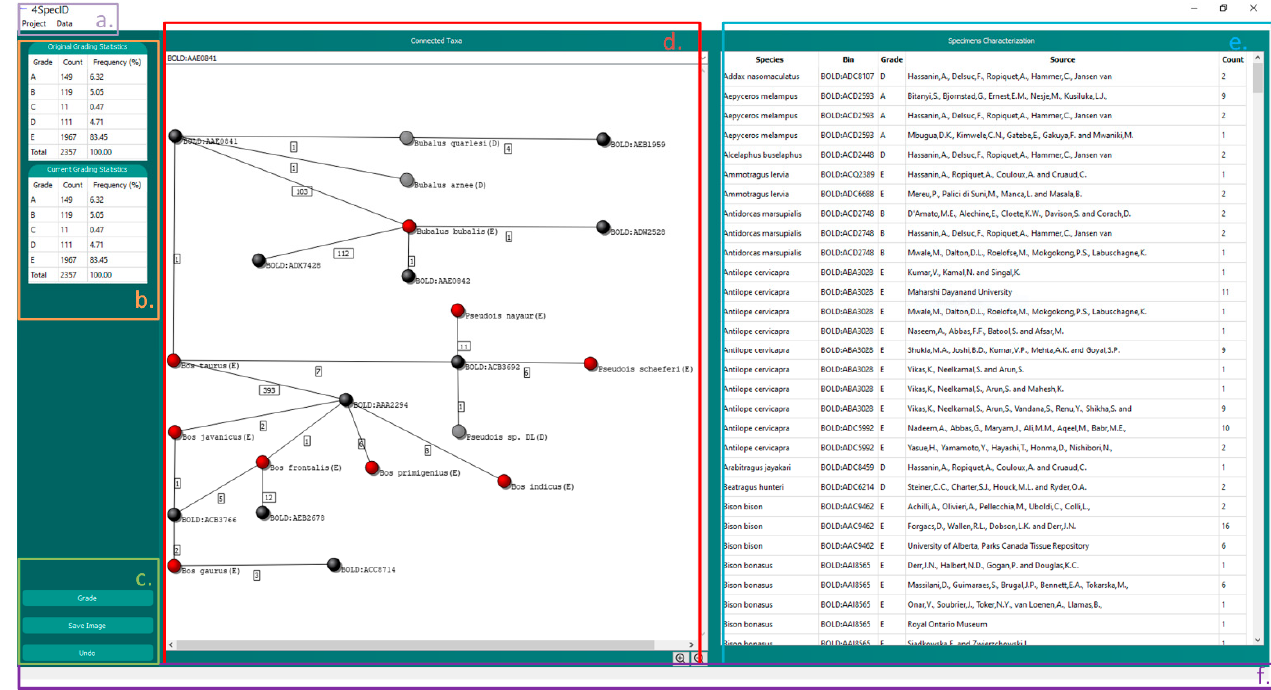
Figure 4. The 4SpecID User Interface: ( a ) Navigation Bar; ( b ) Statistical Results; ( c ) Action Buttons; ( d ) Graph Visualizer: nodes representing genetic clusters are colored in black, and nodes representing species graded as D and E are colored in gray and red, respectively; ( e ) Record Editor; and ( f ) Status Viewer.